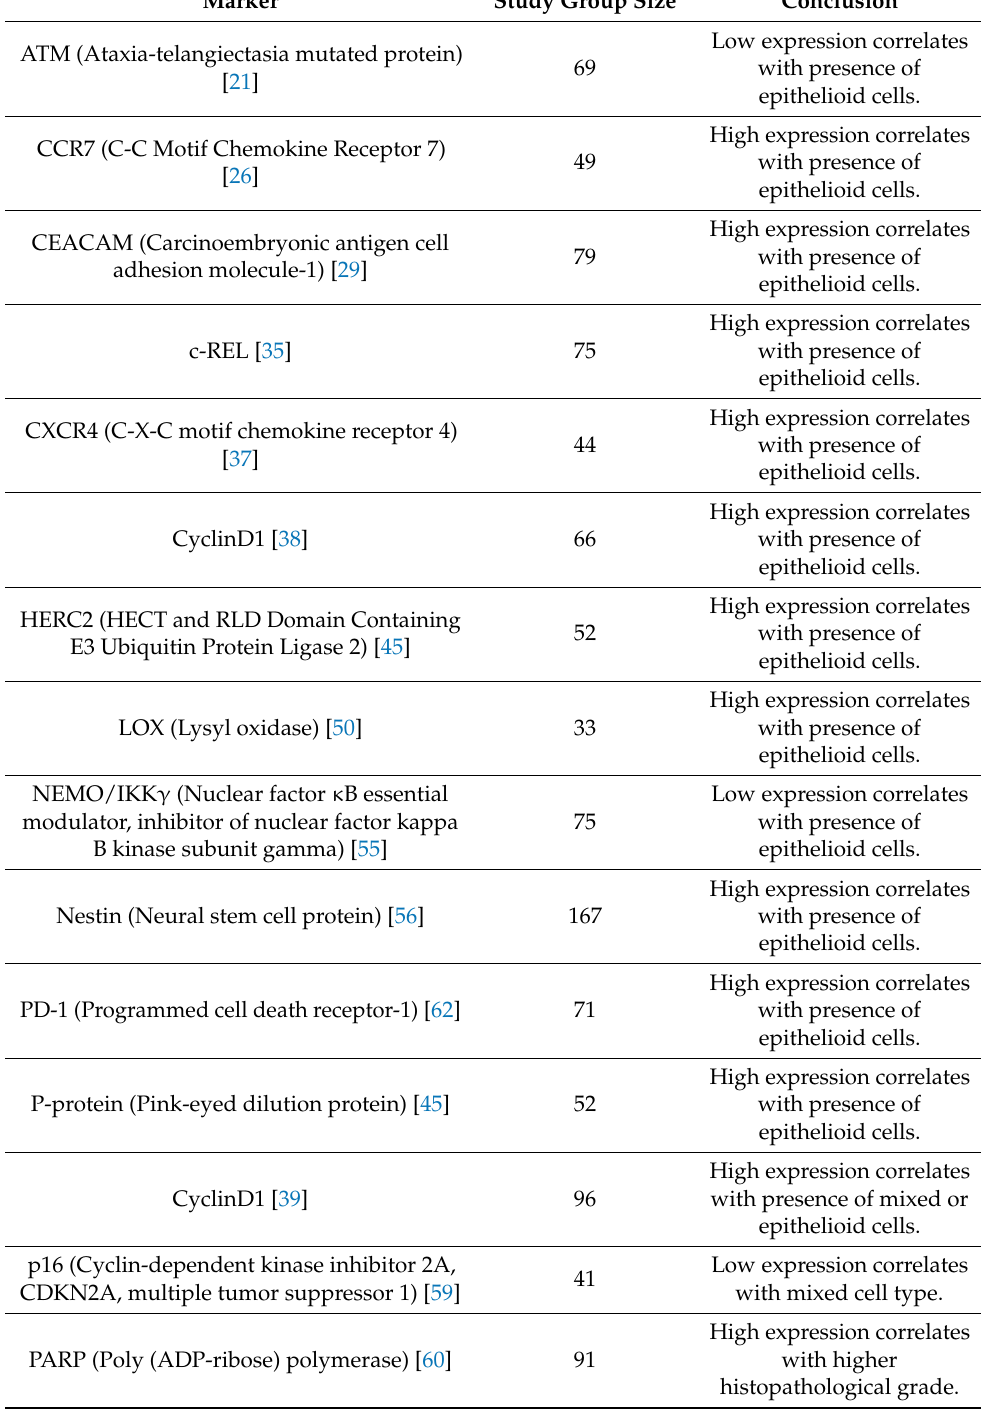
Table 5. Summary of markers whose expression is related to presence of various cell types. Marker Study Group Size